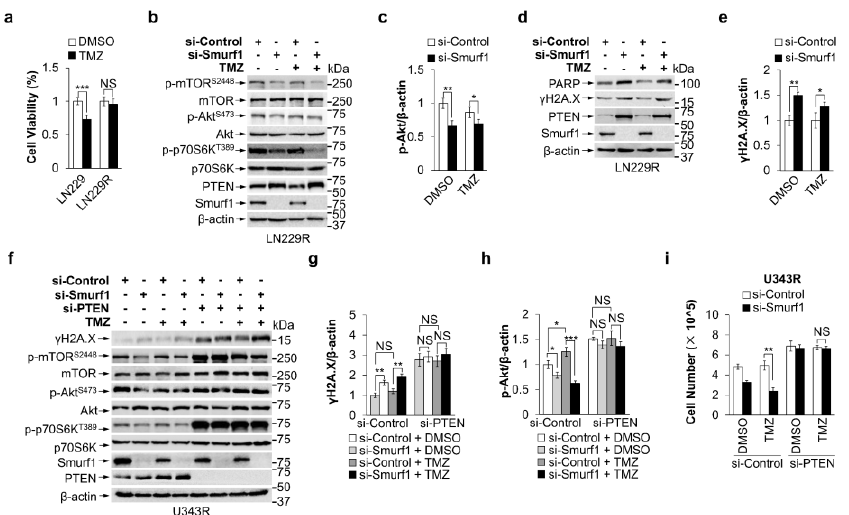
Figure A3. Smurf1 suppression restores the sensitivity of TMZ-resistant GB cells. ( a ) Cell viability was measured after 48 h treatment with DMSO or TMZ (250 µ M, 48 h) in LN229 and LN229R using MTT assay. ( b – e ) LN229R cells were transfected with control or Smurf1 siRNA oligos followed by DMSO or TMZ (250 µ M, 48 h) treatment. Western blot analysis with the indicated antibodies ( b , d ). The graph shows the relative p-Akt ( c ) and γ H2A.X ( d ) intensity. Values were normalized against the amount of LN229R treated with control siRNA oligos and DMSO. ( f – i ) U343R cells were transfected with control, Smurf1, or PTEN siRNA oligos, followed by DMSO or TMZ (250 μM, 48 h) treatment. Western blotting was employed to detect target proteins ( γH2A.X, p− mTOR S2448 , mTOR, p − AKT S473 , AKT, p − p70S6K T389 , p70S6K, Smurf1, PTEN, and β− actin) ( f ). The graph on the right shows the relative γH2A.X ( g ) and p − AKT ( h ) intensity. Values were normalized against the amount of U343R treated with control siRNA oligos and DMSO. The number of cells in each group was counted ( i ). In ( b , d , f ), Western blot analysis was performed in n = 3 biological replicates. In ( a , c , e , g – i ), data are presented as mean ± SD of three separate experiments, NS p > 0.05, * p < 0.05, ** p < 0.01, *** p < 0.001 as determined by unpaired two −tailed Student’s t − test.